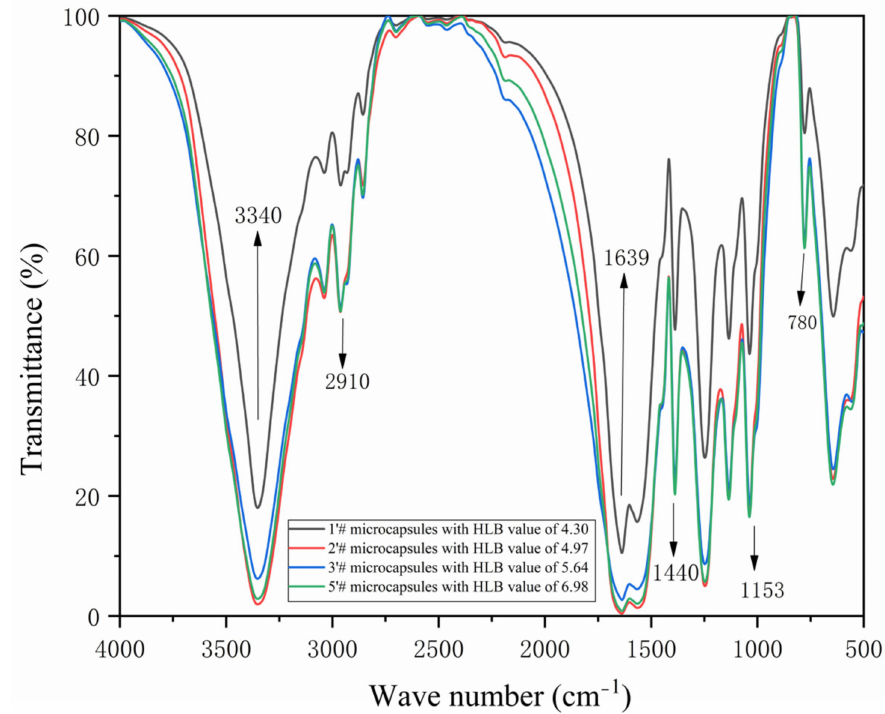
Figure 13. Infrared spectrum of microcapsules with HLB values of four emulsifiers: 1 (cid:48) #, 2 (cid:48) #, 3 (cid:48) #, 5 (cid:48)